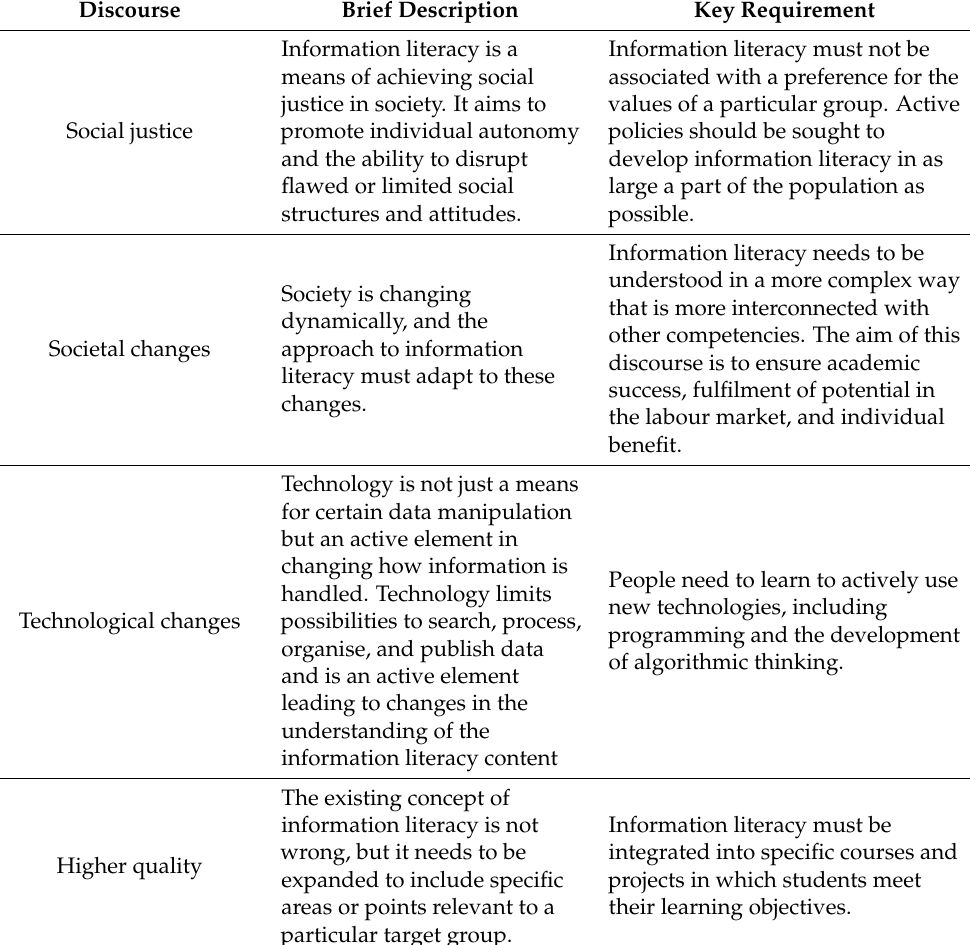
Table 1. Identification and description of discourses and their requirements for